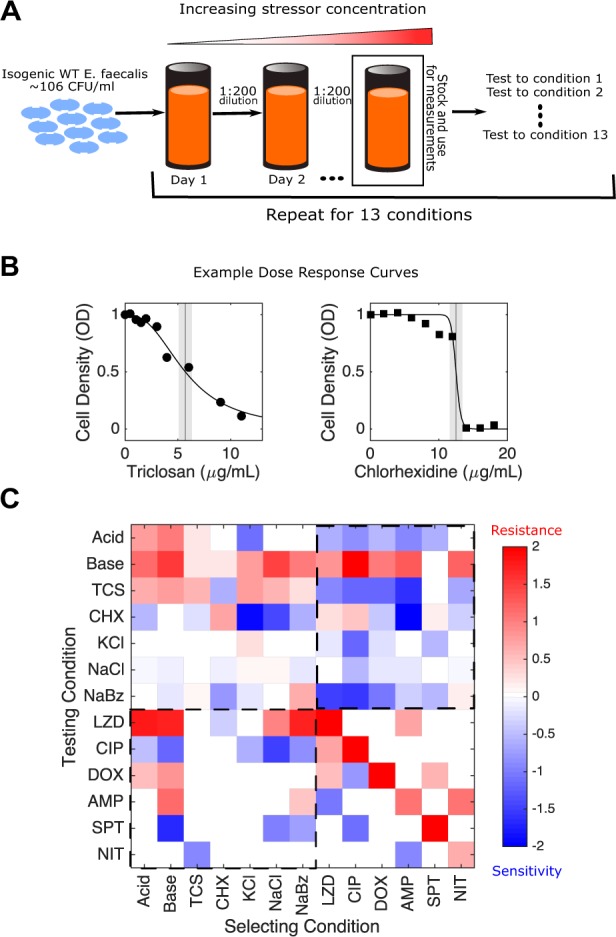
Laboratory evolution reveals collateral sensitivity and cross-resistance between antibiotics and environmental stressors in Enterococcus faecalis. (A) Populations of E. faecalis V583 were exposed to increasing concentrations of a single selecting condition over multiple days via serial passage experiments (Materials and Methods). The evolution was repeated for 13 different selecting conditions, including six antibiotics and seven nonantibiotic stressors (table 1). At the end of the evolution experiment, a single colony was isolated from each population and tested for modulated sensitivity to each of the 13 environmental conditions. (B) Example dose–response curves for isolates selected by TCS (left) and chlorhexidine (right). Vertical line represents estimated half-maximal inhibitory concentration (IC50), with shaded regions confidence intervals (95%). (C) Resistance (red) or sensitivity (blue) to each condition is quantified using the (log2-transformed) fold change in the IC50 for the selected isolate relative to that of ancestral (V583) cells. Dashed regions correspond to antibiotic susceptibilities of nonantibiotic selected isolates (lower left) and, conversely, nonantibiotic susceptibilities of antibiotic selected isolates (upper right).